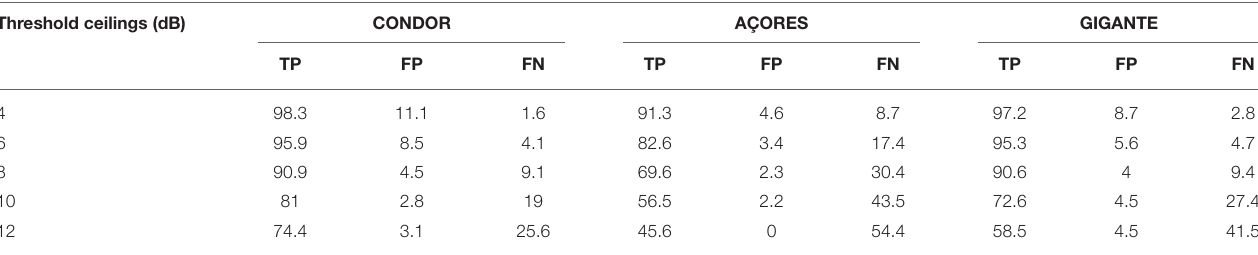
TABLE 2 | Percentages of True Positives (TP), False Positives (FP), and False Negatives (FN) resulting from the comparison between boat detections applying the ATL function with different threshold ceilings (C) and visually confirmed boats in the spectrogram. Threshold ceilings (dB) CONDOR AÇORES